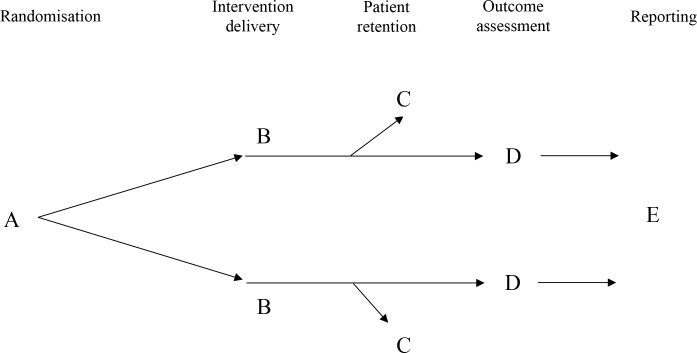
Conceptual framework that underlies the Cochrane risk of bias tool for RCTs.Letters A-E denote the sources of bias listed in Table 1.